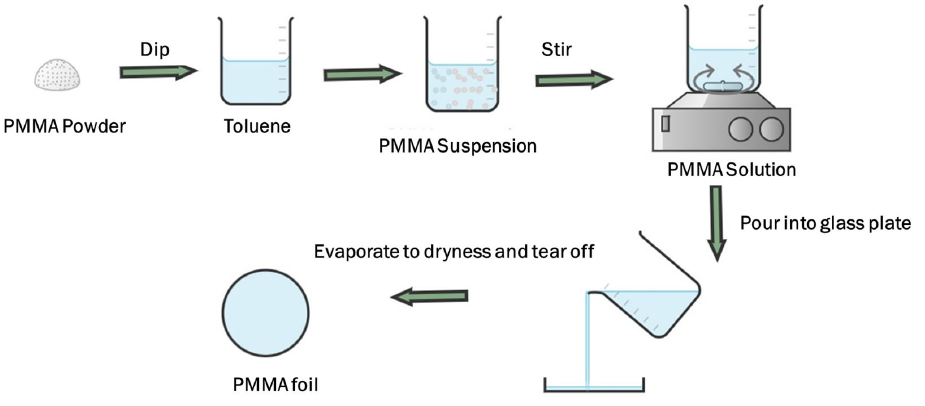
Figure 1. Schematic diagram of PMMA polymer foils by casting method. The PMMA foils from different S/L ratios using the solution casting method.